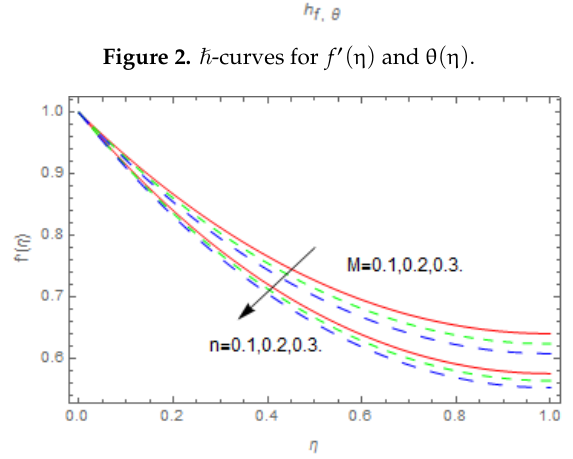
Figure 2. (cid:125) -curves for f (cid:48) ( η ) and θ ( η ) .